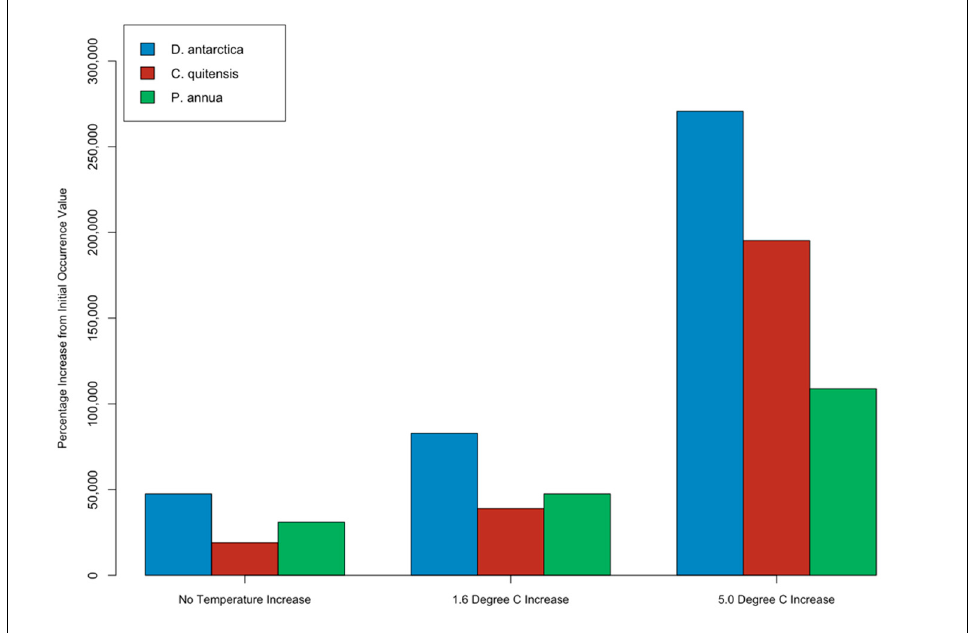
Figure 13. D. antarctica, C. quitensis and P. annua Percentage Increases from Initial Occurrence Value.